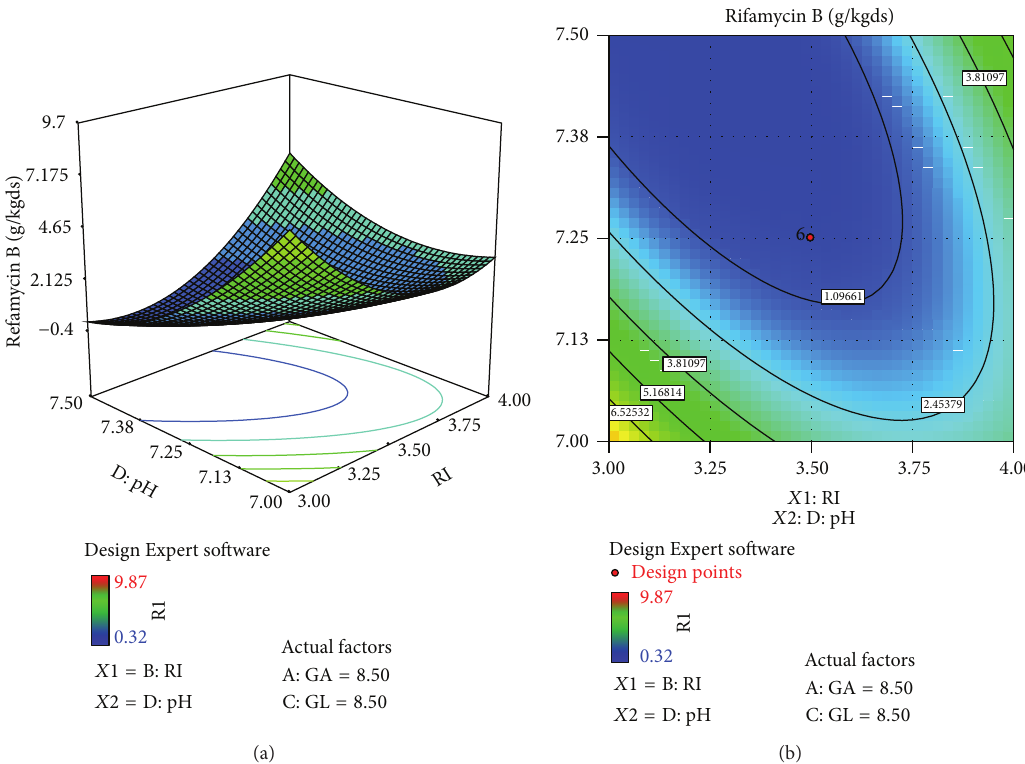
Figure 11: Surface and contour plot for rifamycin B production at varying levels of 𝑋3 , ribose (RI), and 𝑋10 , pH.